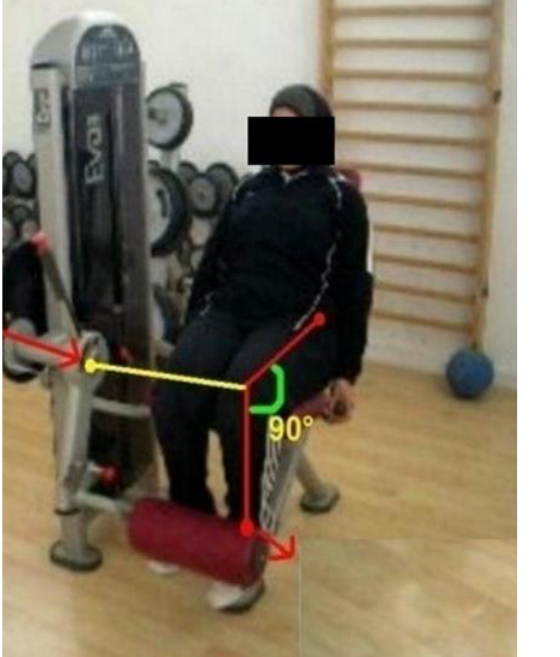
Figure 2. 1-RM prediction of knee flexor muscles. 2.8. Training Program Participants from G50, G75 and G50/75 participated in a 12-week-combined training program with a frequency of 5 sessions/week. A total of 60 training sessions were con- ducted for each group under the supervision of a qualified and certified physical educa- tion teacher and medical supervisor. Due to their initial sedentary state, participants per- formed a progressive load training-program. The training sessions progressed through- out the 12 weeks of training from 20 to 60 min of effective work as previously described by Mezghanni et al. [51,52]. During exercise, HR was controlled with a Polar heart rate monitor (Polar Electro, S610). The exercise intensity was adjusted on an individual basis to ensure each subject exercised at their prescribed intensity based on their target heart rate (HR) calculated from Karvonen’s method [53]. This method is based on the maximal